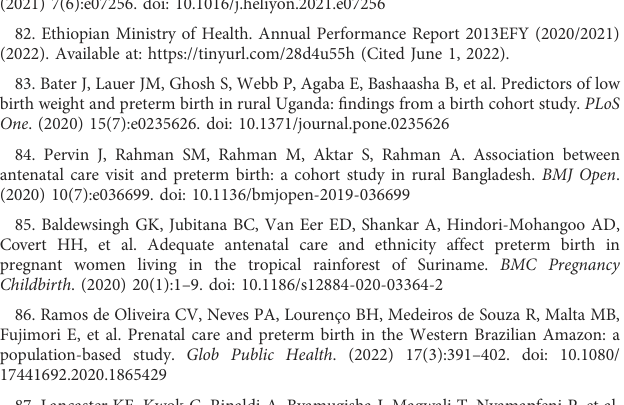
59. United Nations. World population prospect. Population division (2022) Available at: https://population.un.org/wpp/ (Cited June 18,